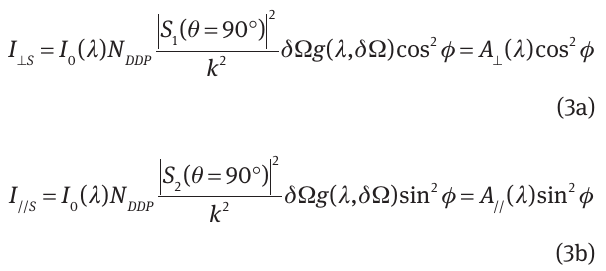
Figure 5 illustrates the data collected on sample S3-C. The perpendicular and parallel signals I and I plotted ⊥ S // S at a wavelength of 640.5 nm are fitted to simple functions A cos 2 φ + B and A sin 2 φ + B , respectively. The background ⊥ // signal B, identical for the two functions, does not exceed a few percent (2–7.5% across the wavelength range) of the amplitude A , which supports the assumption of iso- ⊥ tropic scatterer [32].